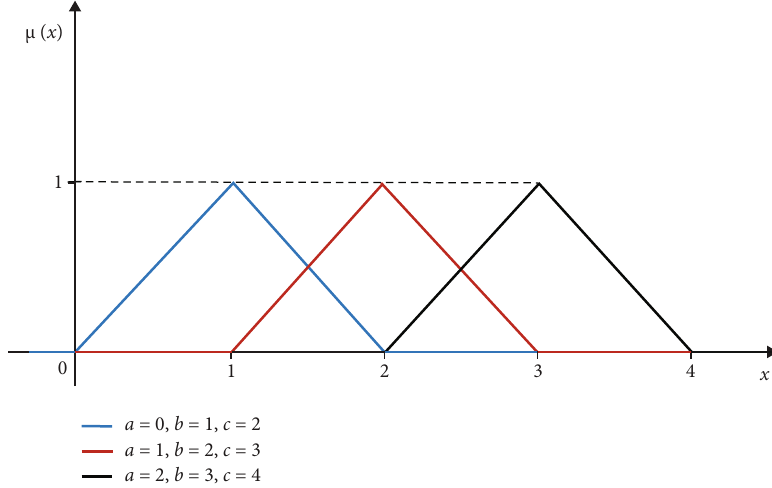
Figure 2: Fuzzy sets with the di ff erent triangular membership functions MF